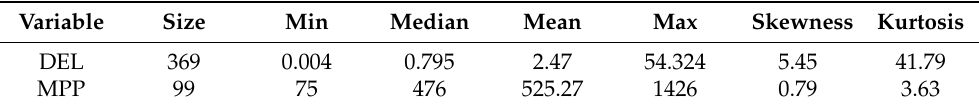
Table 1. Descriptive analysis of direct economic loss (DEL) in billion yuan and maximum point precipitation (MPP) in millimeters.